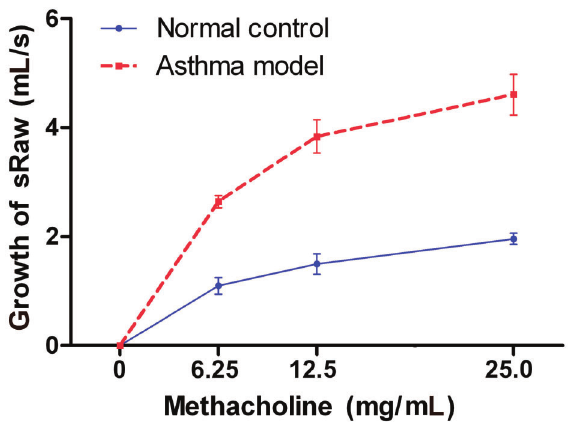
Figure 2. Change in speci fi c airway resistance (sRaw) of mice after being sensitized and challenged with ovalbumin and inhalation of different concentrations of methacholine compared with the control group (P o 0.05). Data are reported as means ± SD (Student ’ s t -test).